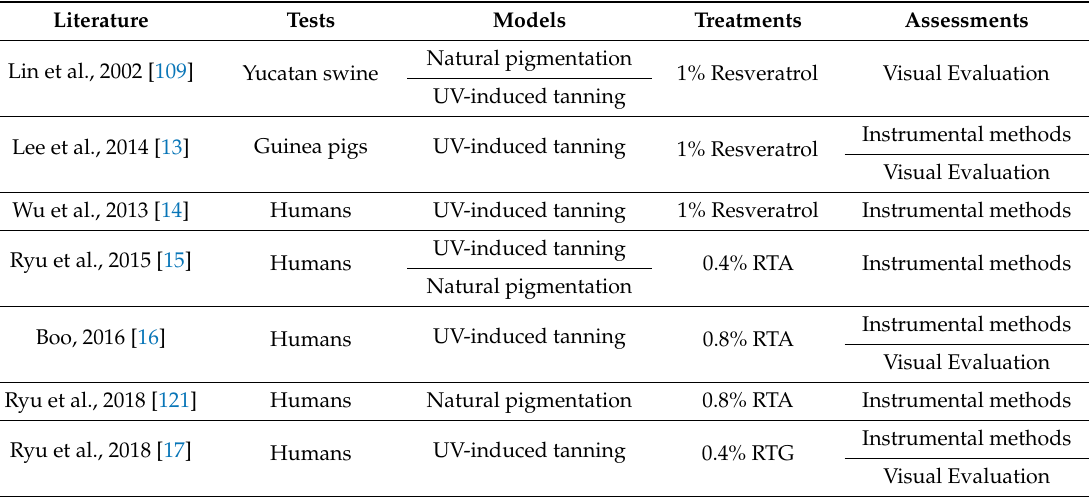
Table 1. In vivo and clinical studies on the skin lightening e ffi cacy of resveratrol and its